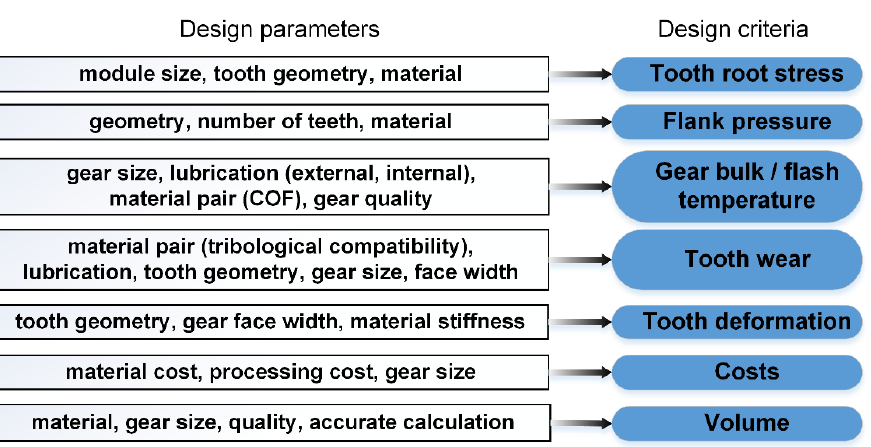
Figure 8. Durability gear testing on test rig with control of speed, torque, and temperature. The pinion is connected to the shaft of the electric motor and is made of steel. The pinion meshes with three planet wheels made of plastic (Figure 9a). The planet gears ro- tate at a high speed, so it is important to dampen the vibrations with plastic. The ring gear is also made of plastic. The gear pair on the second stage initially consisted of a steel pinion and a plastic gear (Figure 9b). Due to the changed requirements (maximum load) and the limited volume, the material of gear (Figure 9b) was later changed to steel.